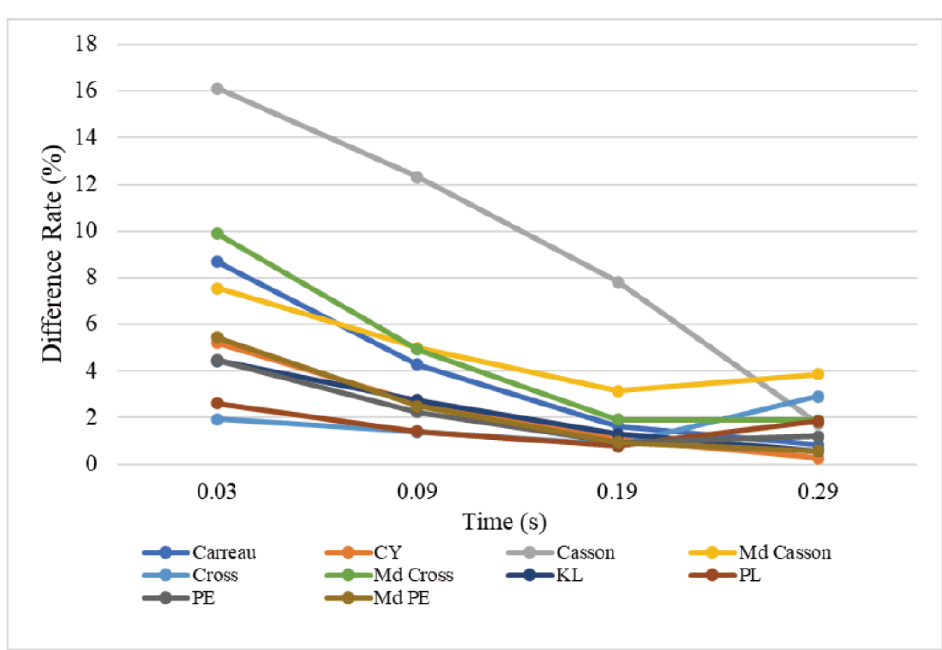
Figure 17. The rate of difference between non-Newtonian and Newtonian models. Additionally, modified Cross, Carreau, CY, PE, and Modified PE can explain the shear-thinning of blood in an MHV. The low-velocity phase produces a higher viscosity; consequently, the mean WSS is greater than the Newtonian model. During the jet the blood is shear-thinned, and the non-Newtonian model viscosity tends toward the